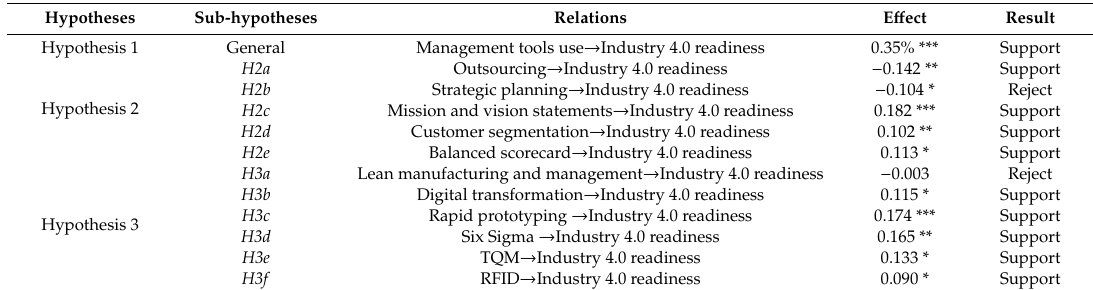
Table 4. Hypotheses